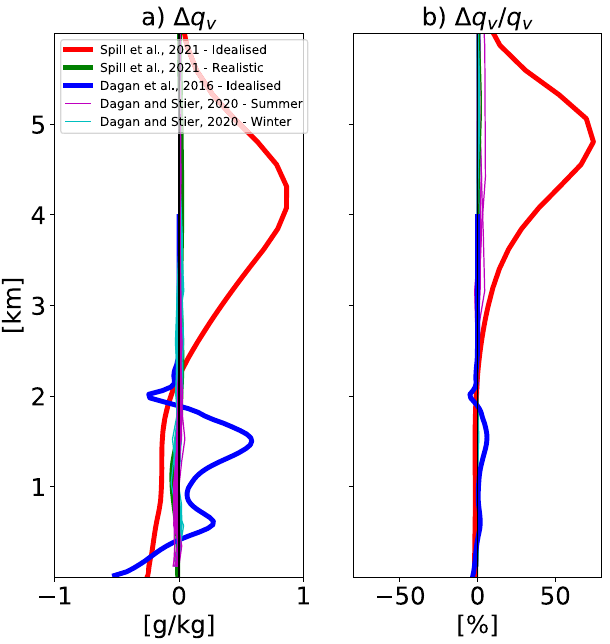
Fig. 3 Water vapor mixing ratio response to aerosol perturbation in shallow-convective clouds simulations. Vertical pro fi les of the domain and time mean a change in water vapor mixing ratio — q v , and b relative change in q v due to an aerosol perturbation (normalized to an order-of-magnitude increase in aerosol concentration) from 45 different sets of simulations of shallow-convective cloud fi elds representing a wide range of environmental conditions and produced by different models. The blue and red curves present results from simulations with idealized BCs, while the rest of the curves are based on realistic simulations (see Fig. 4 for a more detailed view). For details about the different simulations, please see the Methods